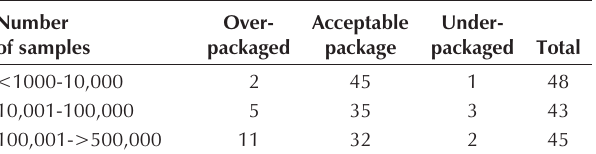
Reported number of samples processed in the